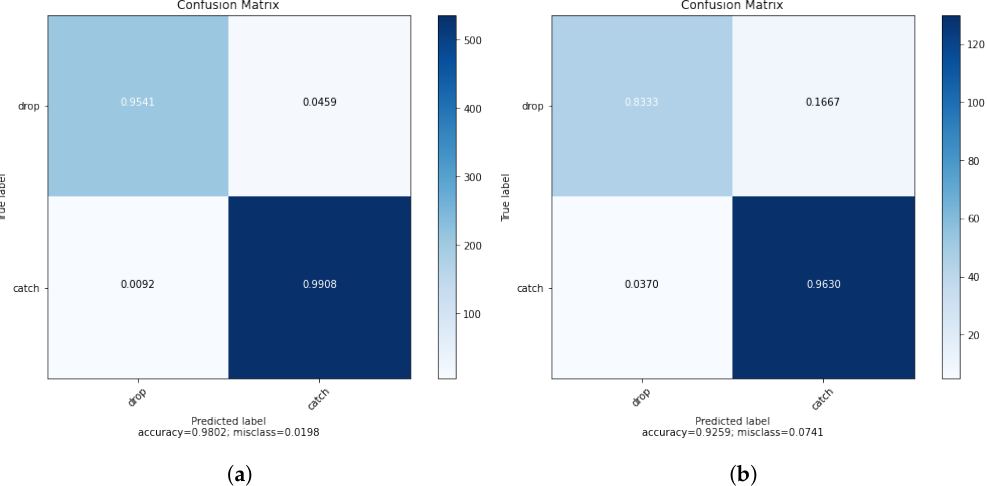
Figure 5. The normalized confusion matrices show the classification accuracy as comparision between the predicted catches/drops and the real catches/drops. ( a ) shows the matrix of the whole dataset,